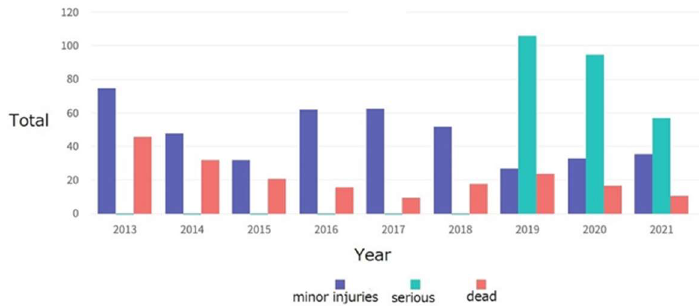
Figure 7. Total number of accidents in mining companies including gold mining (Source: Ministry of Energy and Mineral Resources). Table 5. Victims of illegal mining over the last 5 years (Source: online